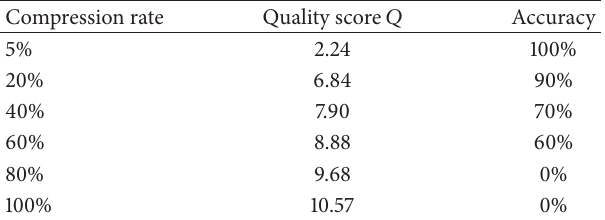
Table 2: Detection accuracy in different image quality.